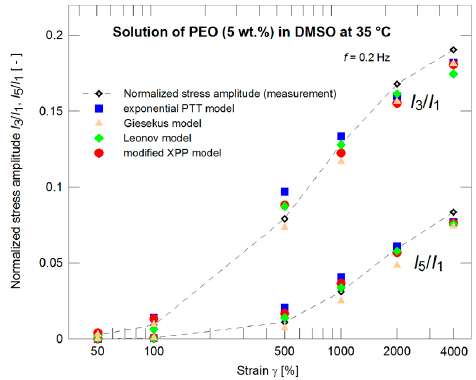
Figure 5. A description of the normalized stress amplitudes by the exponential PTT, Giesekus, Leonov, and modified XPP models using the nonlinear parameters optimized with respect to the steady shear viscosity measurements (Figure 4) for strains of 50%, 100%, 500%, 1000%, 2000%, and 4000%.